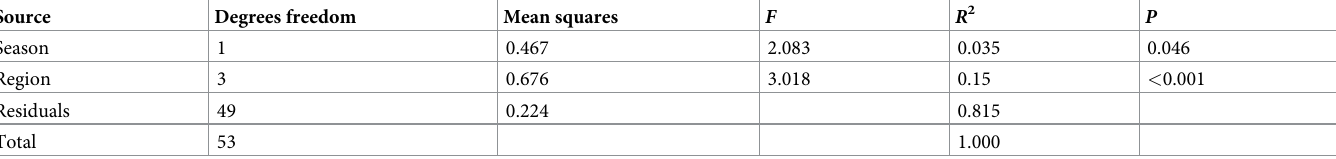
Table 4. PERMANOVA of species composition of the seabird community in the northeastern Chukchi Sea, 2008–2018.